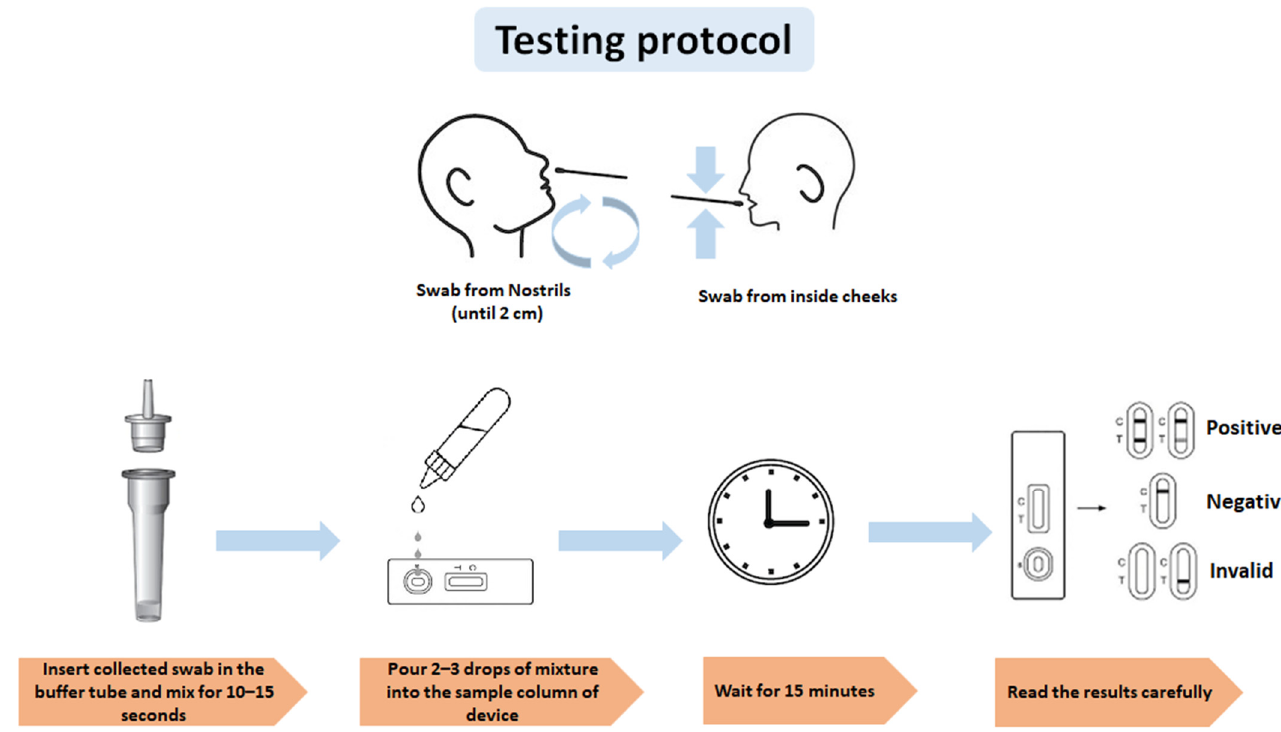
Figure 1. Testing protocol for RTK test using nasal and buccal swabs.